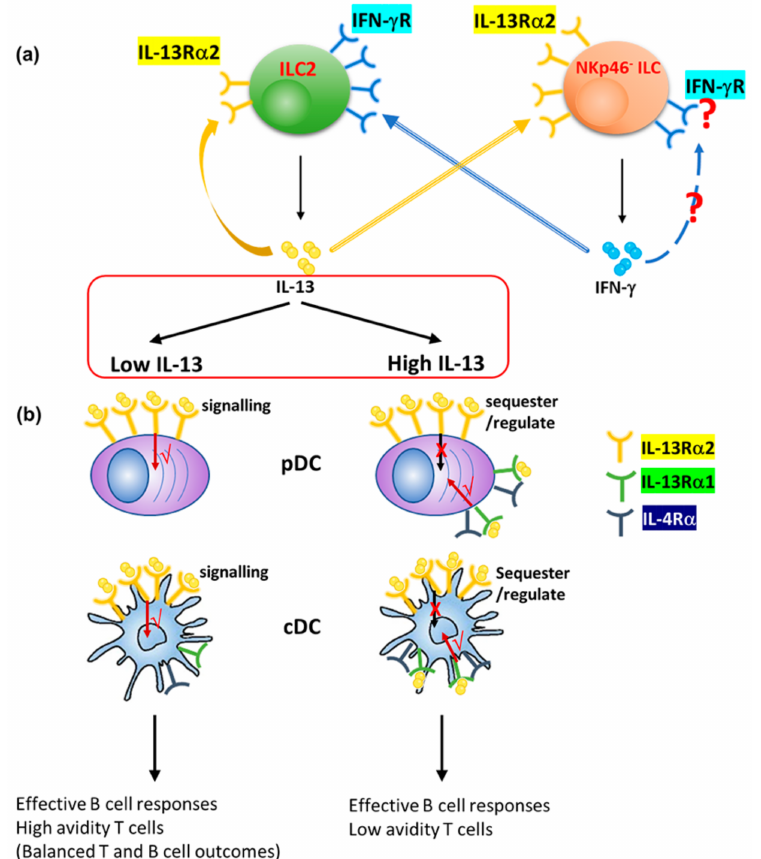
Figure 8. Schematic diagram showing the proposed co-regulation of ILC2-derived IL-13, inter- regulation of ILC2 and ILC1/ILC3 and DC under high and low IL-13. ( a ) At 24 h post viral FPV-HIV vaccination, lung IL-33R/ST2 − ILC2-derived IL-13 and IL-13R α 2 were co-regulated. Moreover, the ILC2-derived IL-13 and NKp46 − ILC1/ILC3-derived IFN- γ were also inter-regulated by their respective receptors (IFN- γ R and IL-13R α 2) present on these ILCs. Taken together our findings indicate that at the early stages of vaccination, IL-13 is the master regulator of different ILC subsets. However, whether there is regulation of IFN- γ via IFN- γ R on ILC1/ILC3 warrants further investiga- tion. Moreover, see Figure S8 for STAT6 and IL-13 transient versus permanent inhibition scenarios. ( b ) Under low (rFPV) and high (rVV) IL-13 conditions DCs are differentially regulated. Under low IL-13 conditions, IL-13 signals via the high affinity receptor IL-13R α 2 on pDCs and cDCs, inducing effective B cell (e.g., differentiated antibody responses) as well as high avidity/polyfunctional T cells responses [32,33,36,37]. Under high IL-13 conditions, IL-13 signals via the low affinity Type II IL-4 receptor IL-13R α 1/IL-4R α complex, on pDCs and cDCs, while IL-13R α 2 sequesters/regulates excess IL-13 at the vaccination site maintaining homeostasis, resulting in effective B cell but not T cell